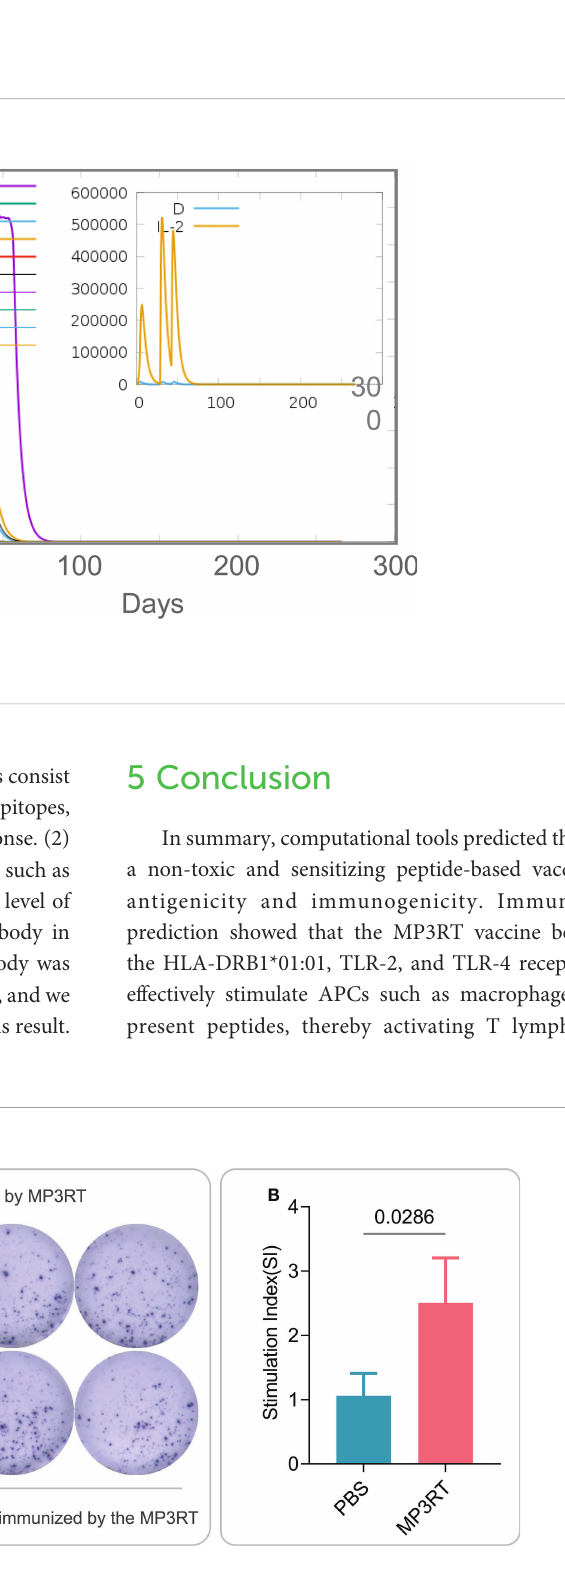
FIGURE 10 IFN- g + T lymphocytes detection with ELISPOT in mice. (A) The splenocytes collected from mice immunized with PBS or MP3RT vaccine were stimulated with MP3RT in vitro , and the SFCs were detected using a mouse ELISPOT kit. (B) The number of IFN- g + T lymphocytes (showed as SI) stimulated by the MP3RT vaccine in PBS and MP3RT groups were compared. In order to reduce individual differences, the spleens of mice in each group were mixed to prepare spleen cell suspensions, and then ELISPOT experiments were performed in quadruplicate. The results were analyzed with the Unpaired t-test or Mann-Whitney test according to the normality. All data were shown as mean + SEM ( n = 4). P < 0.05 was considered signi fi cantly